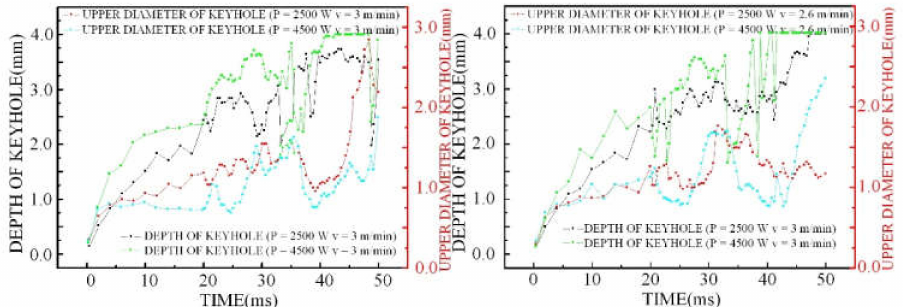
Figure 10. Effect of laser power on keyhole depth and outlet diameter of keyhole top.